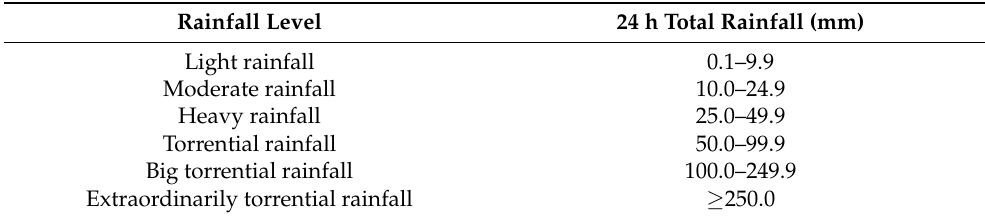
Table 2. Classification standards of the rainfall intensity in the inland areas of